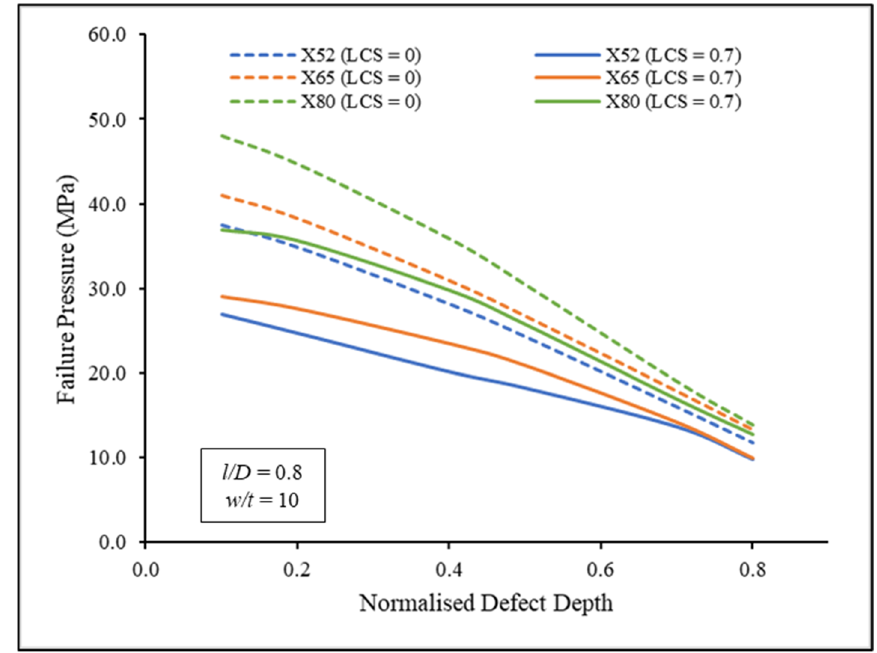
Figure 9. Failure pressure against normalised defect depth, with 0.0 and 0.7 normalised longitudinal compressive stresses for X52, X65, and X80.